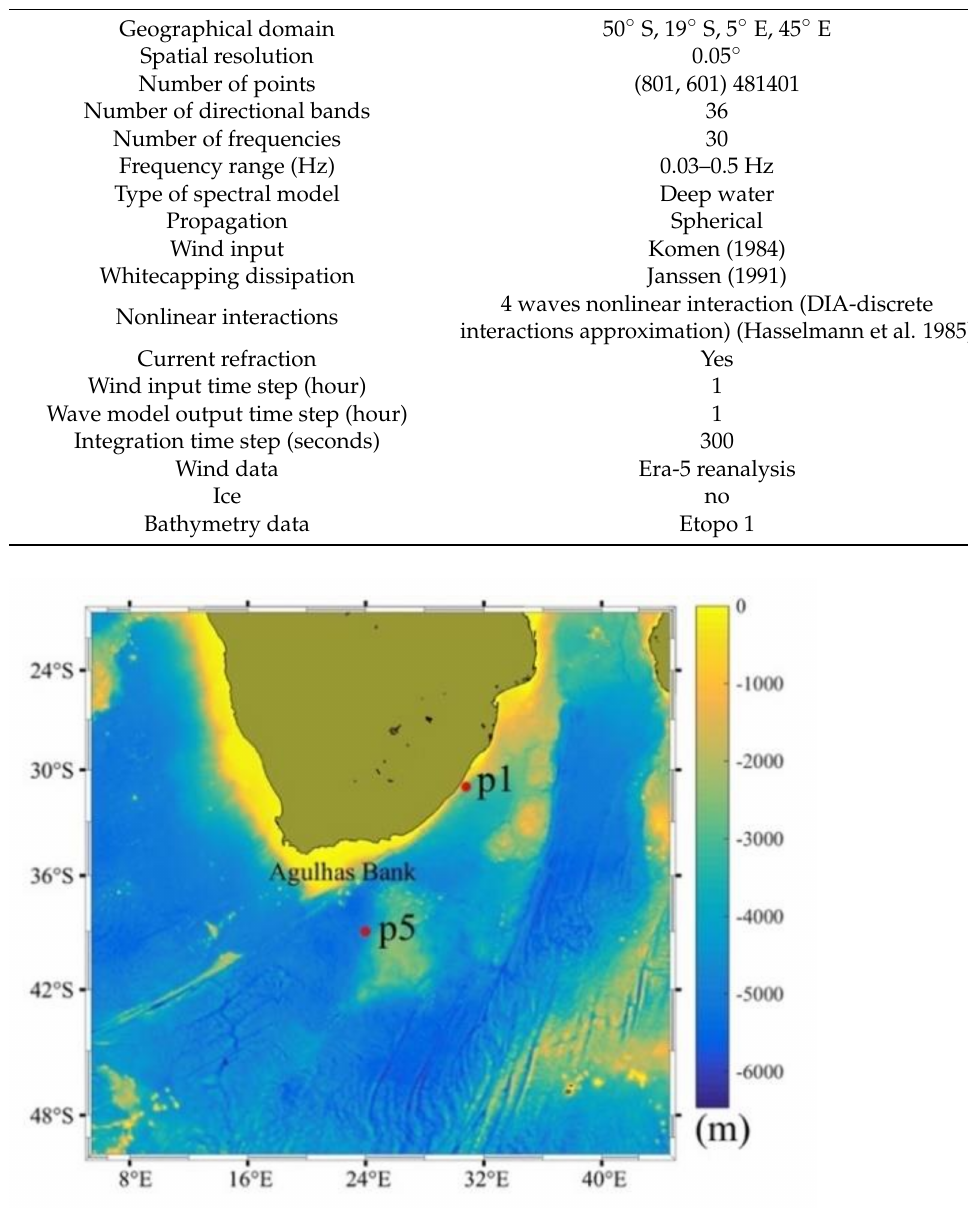
Figure 1. Bathymetry grid and locations of the SWAN outputs. P1 (31 ◦ E, − 31 ◦ S) located in the Agulhas Current (AC) and P5 ( − 38.36 ◦ S, 25 ◦ E) located in the Agulhas Current Retroflection (ACR)